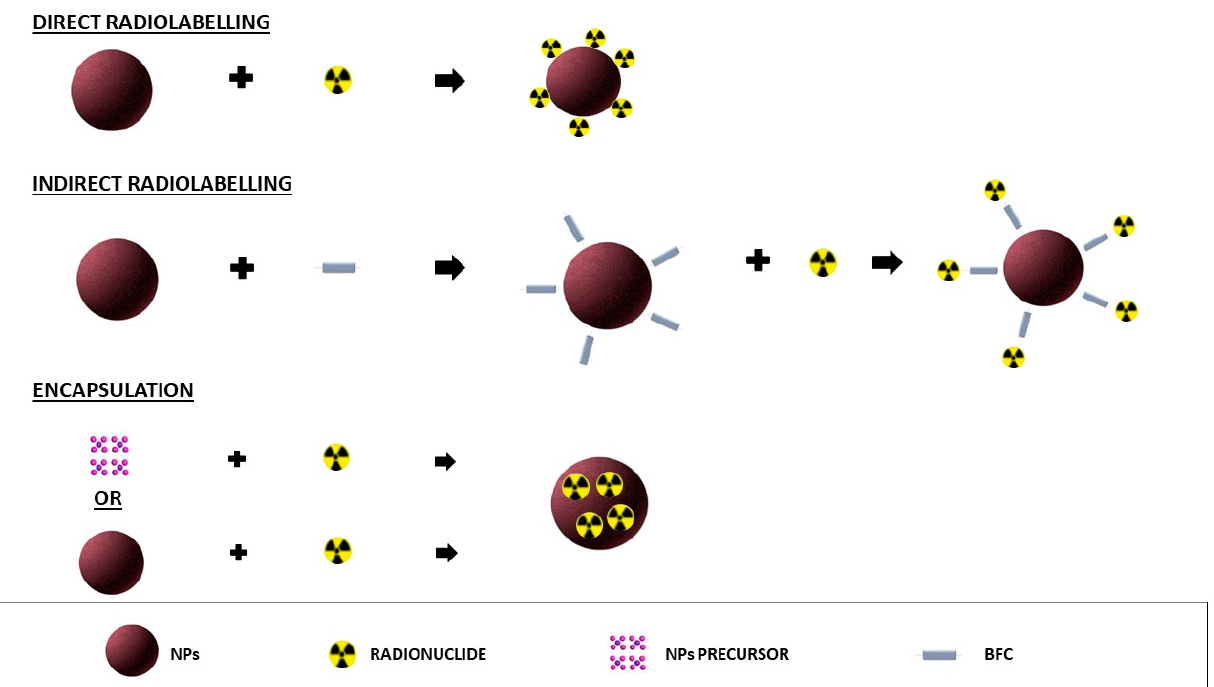
Figure 1. Different radiolabelling methods of NPs.